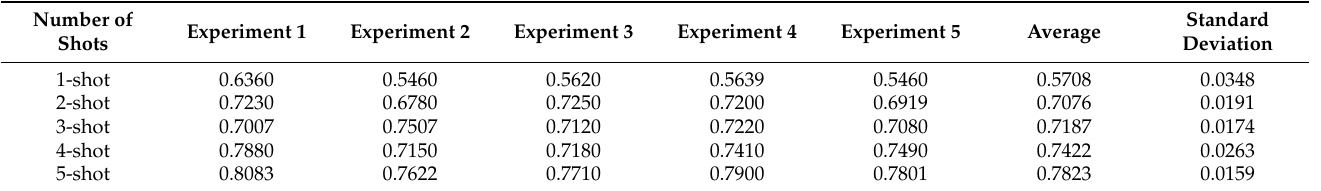
Table 5. Accuracy results of EfficientNetB1 (pre-trained, dropout, augment) with various shots on the validation